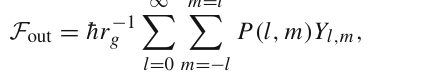
(cid:2) (cid:2) d v d 2 (cid:4) F in = (cid:2)